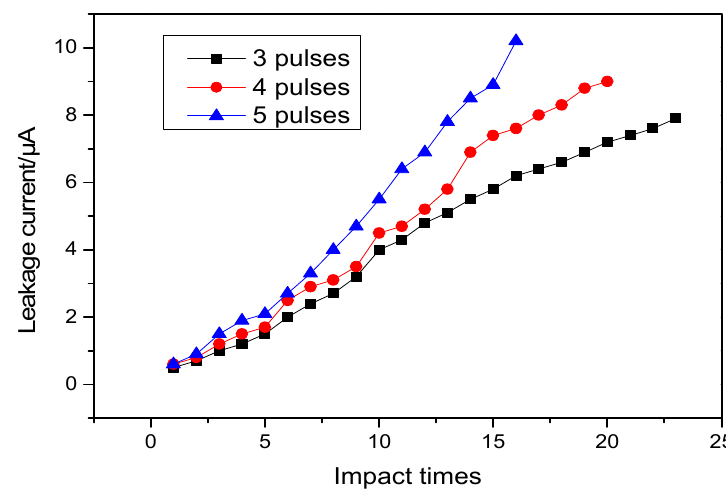
Figure 7. Relationship between the leakage current of ZnO varistors and the impact times under different pulse numbers.